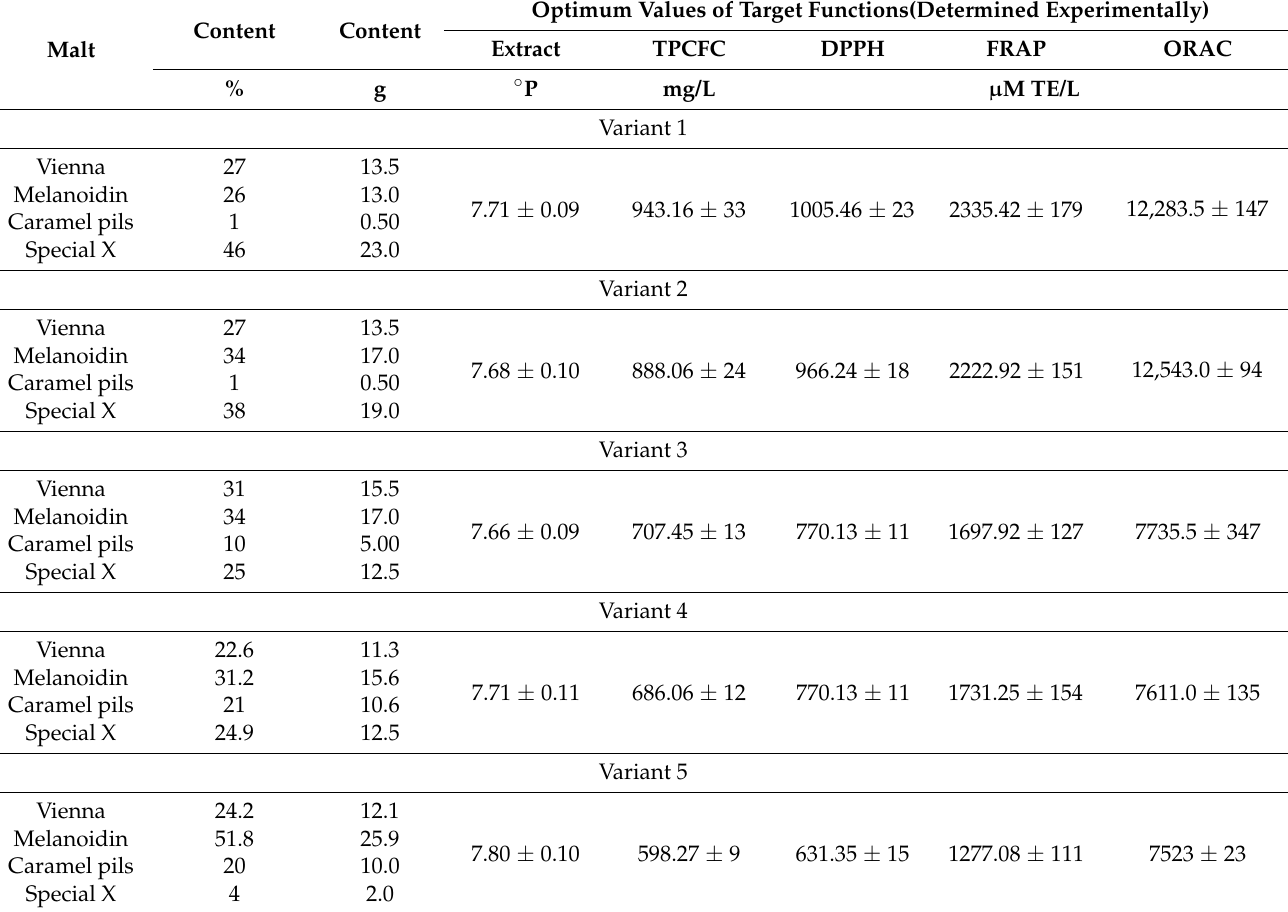
Table 4. Results of multiple response optimization of four–component malt